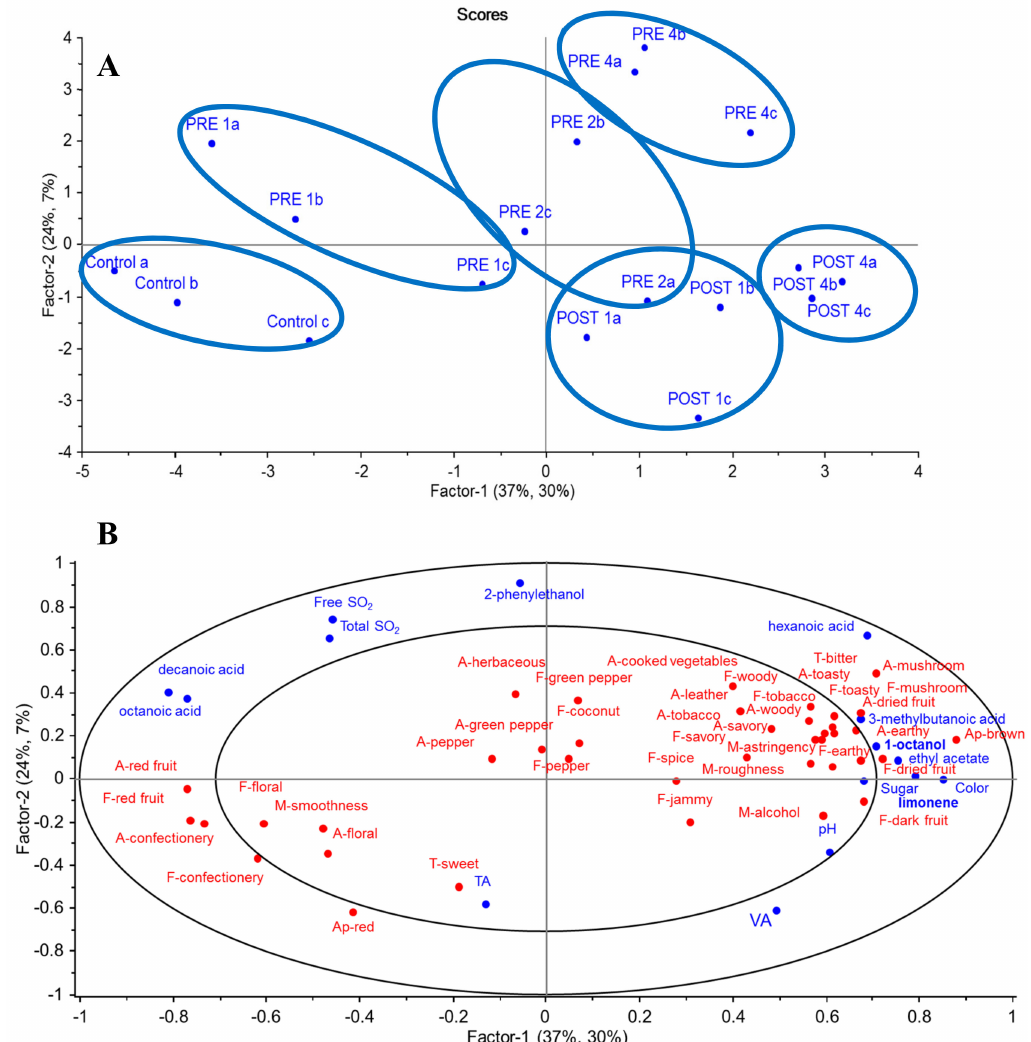
Figure 3. PLS regression and scores plots of significant volatile compounds ( p < 0.05), sensory attributes ( p < 0.05) and basic chemical data for 18 wines (28 L ferments) made with and without GL extracts added pre- or post-fermentation. X-variables: chemical components, Y-variables: sensory descriptors. The inner and outer ellipses represent R 2 = 50% and 100%, respectively. ( A ) sample configuration, prefix PRE = GL extracts added prior to fermentation (PRE 1, PRE 2 and PRE 4) and POST = GL extracts added after the fermentation process (POST 1 and POST 4). ( B ) attribute configuration with prefix A- = aroma attribute; T- = taste, F- = flavor attribute, M- = mouthfeel, Ap- = appearance, FL- = aftertaste (fruit and nonfruit). TA = titratable acidity, VA = volatile